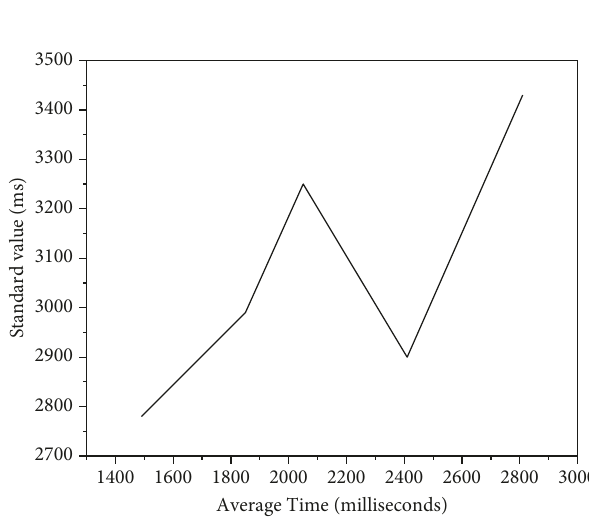
Figure 6: Concurrent test